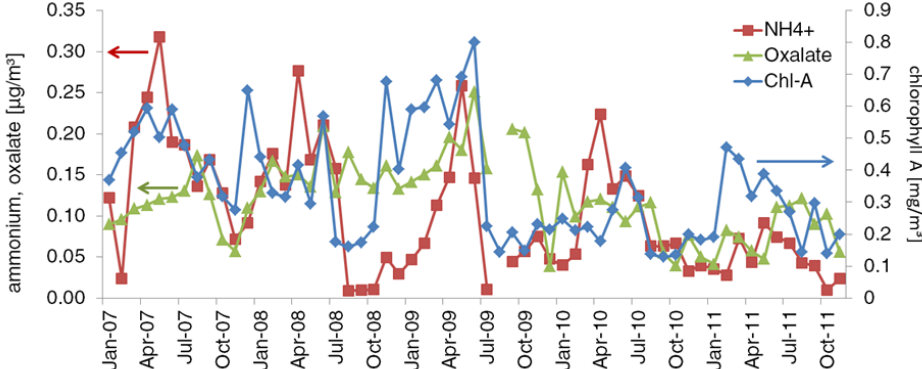
Figure 7. Monthly mean of chlorophyll a in the tropical NE Atlantic (selected area for averaging: lat (16.985, 24.895), lon ( − 24.87, − 18.278)), oxalate and ammonium in PM 10 aerosol samples collected at the CVAO.